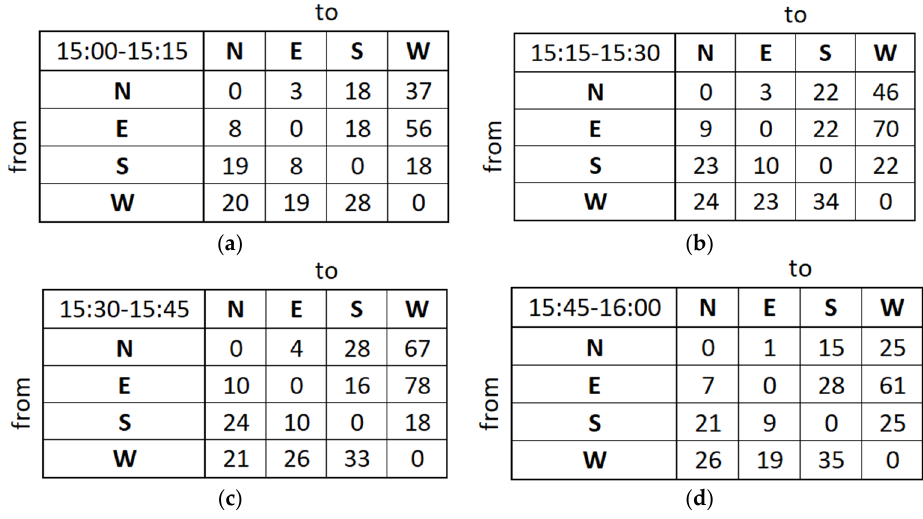
Figure 3. The layout of the intersection of D ą bka Street and Zielona Street [59].